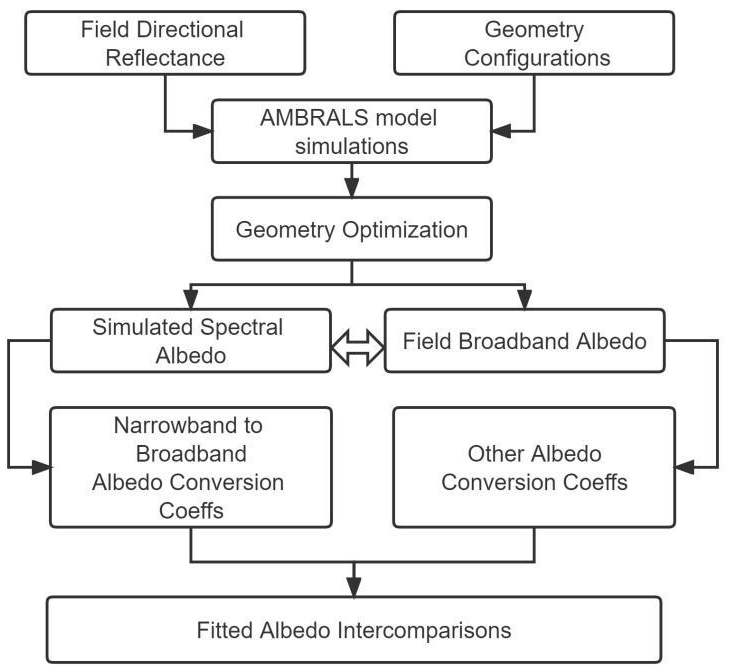
Figure 4. The flowchart of this study.